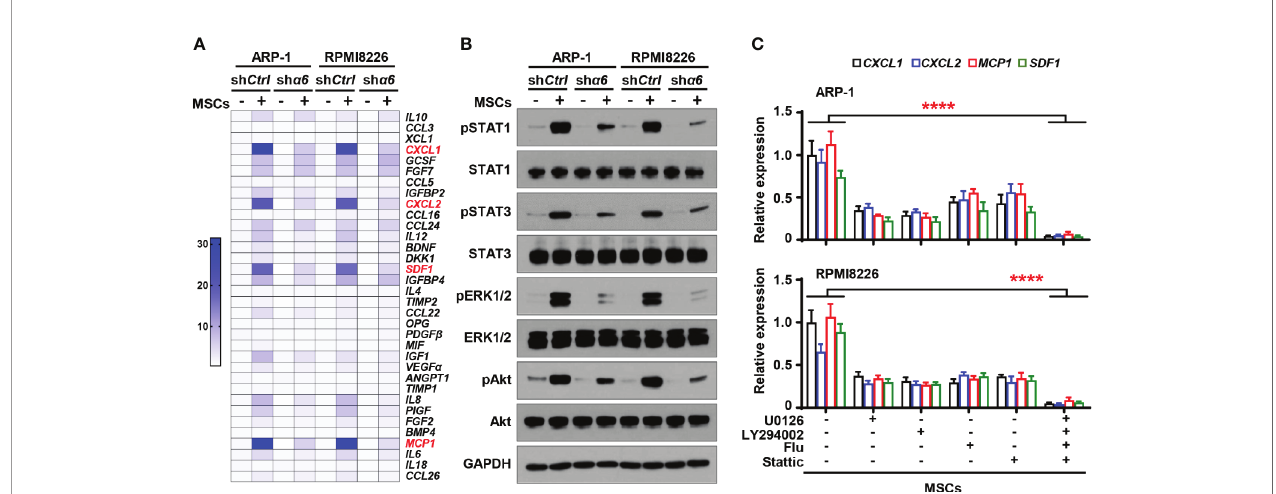
FIGURE 5 | Integrin a 6 regulates myeloma cell cytokines expression via Akt, ERK, STAT1 and STAT3 signaling pathways activated by MSCs. Myeloma cells ARP- 1 or RPMI8226 carrying nontargeted shRNA ( shCtrl ) or ITGA6 shRNA ( sh a 6 ) were cocultured with MSCs for 24 hours. (A) Quantitative real-time PCR analysis shows the relative expression of cytokine genes in ARP-1 or RPMI8226 cells. (B) Western blotting shows phosphorylated (p), or non-phosphorylated ERK1/2, Akt, STAT1 and STAT3 in ARP-1 or RPMI8226 cells. GAPDH levels served as protein loading controls. Representative images are shown from three independent experiments. (C) The relative expression of CXCL1 , CXCL2 , MCP1 and SDF1 mRNAs in ARP-1 cells (Upper panel) or RPMI8226 cells (Lower panel) cultured with MSCs in the absence or presence of the STAT1 inhibitor Fludarabine (10 µM), STAT3 inhibitor Stattic (5 µM), ERK inhibitor U0126 (5 µM) or Akt inhibitor LY294002 (10 µM). Data shown as averages ± SD is a representative of three independent experiments. **** P < 0.0001. All P values were determined using one-way